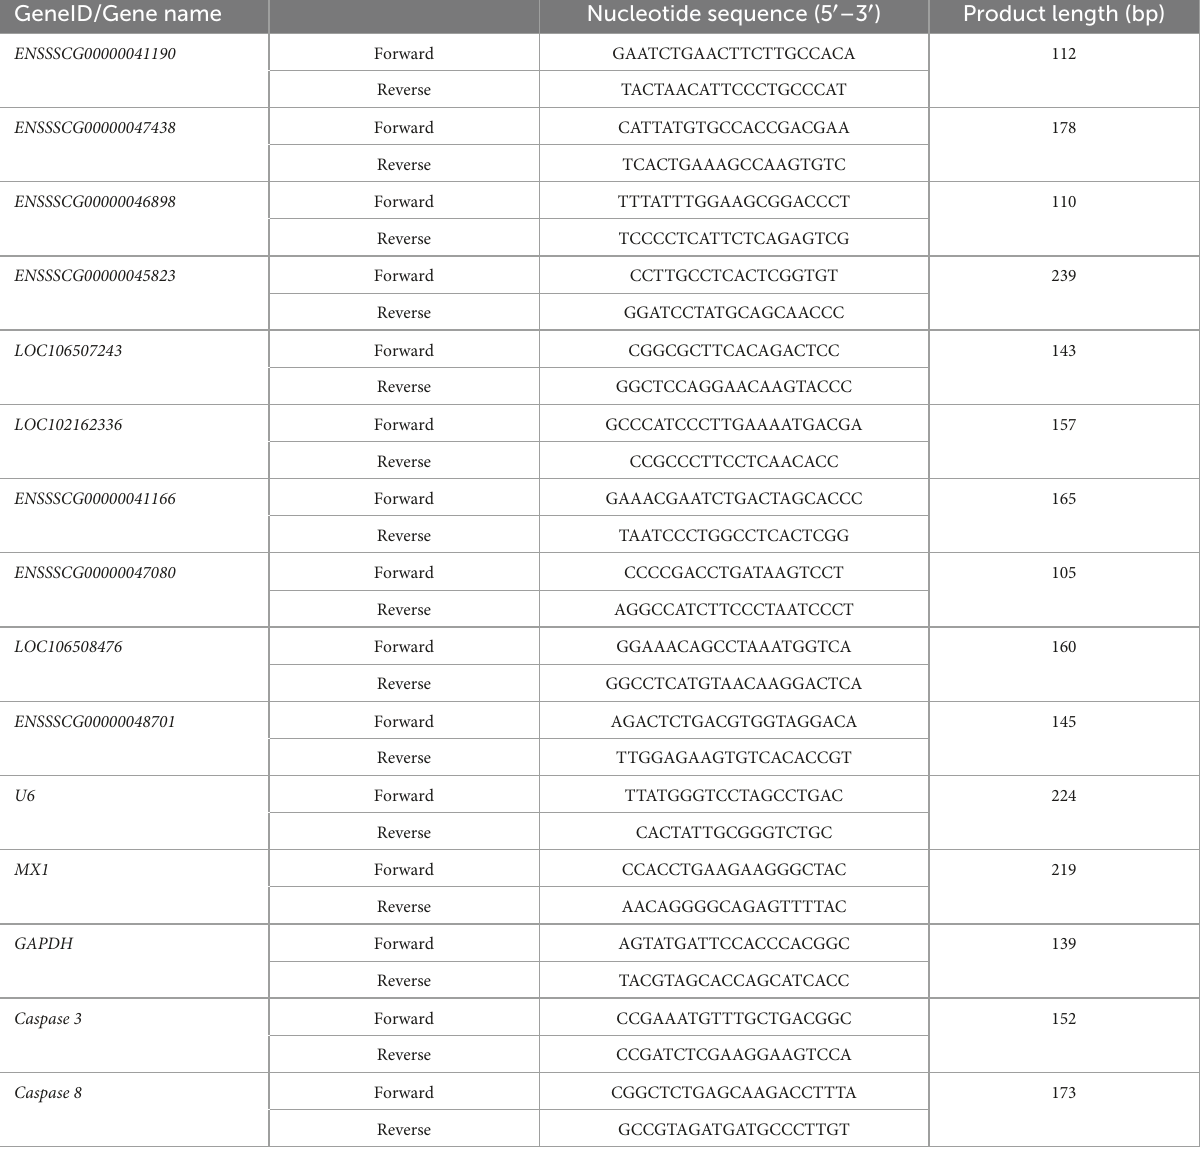
TABLE 1 Quantitative real-time reverse transcription polymerase chain reaction (qRT-PCR) primers for amplifying specific genes. GeneID/Gene name Nucleotide sequence (5 (cid:48) –3 (cid:48) ) Product length